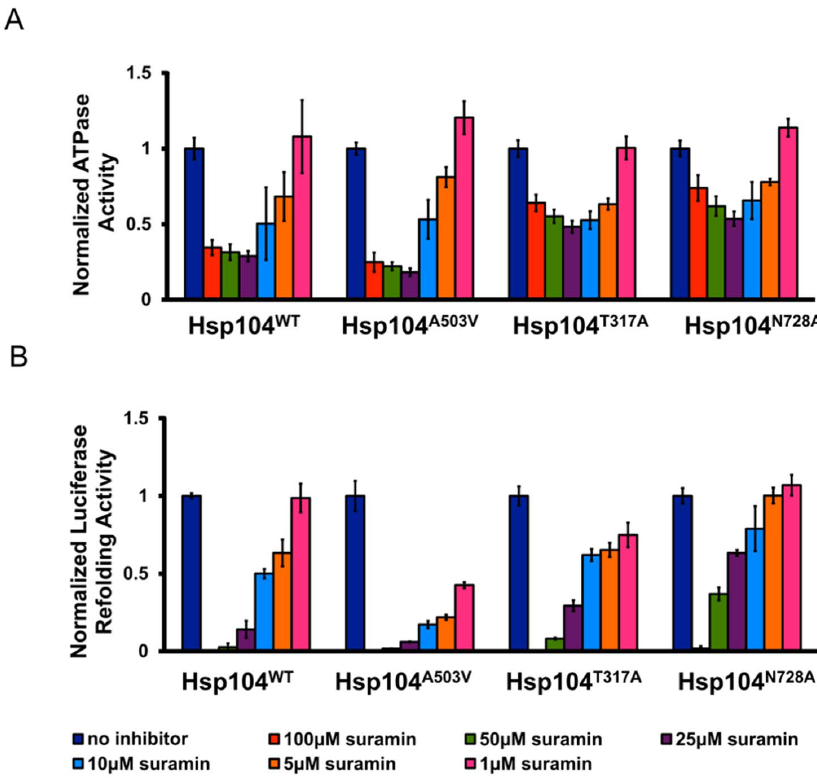
Figure 7. Hsp104 variants respond differently to Suramin than Hsp104 WT . ( A ) Hsp104 variants (0.25 m M monomer) were incubated for 10 min with ATP (1 mM) and varying concentrations of Suramin. The amount of Pi produced was measured by absorbance at 635 nm. Absorbance values were normalized to the absorbance produced by each Hsp104 variant in the absence of inhibitor. Values represent mean 6 S.D. ( n =6). ( B ) Urea-denatured firefly luciferase aggregates were incubated for 90 min at 25 u C with Hsp104 variants (1 m M hexamer) plus 1:1 mixtures of ATP and ATP c S (or ATP alone) and varying concentrations of Suramin. Luciferase reactivation was then determined and normalized to untreated disaggregase activity for each variant in the presence of ATP c S: ATP (or ATP alone). 1:1 mixtures of ATP and ATP c S were used for Hsp104 WT and Hsp104 T317A , while ATP alone was used for Hsp104 A503V and Hsp104 N728A . Values represent mean 6 S.D. ( n =6–12).